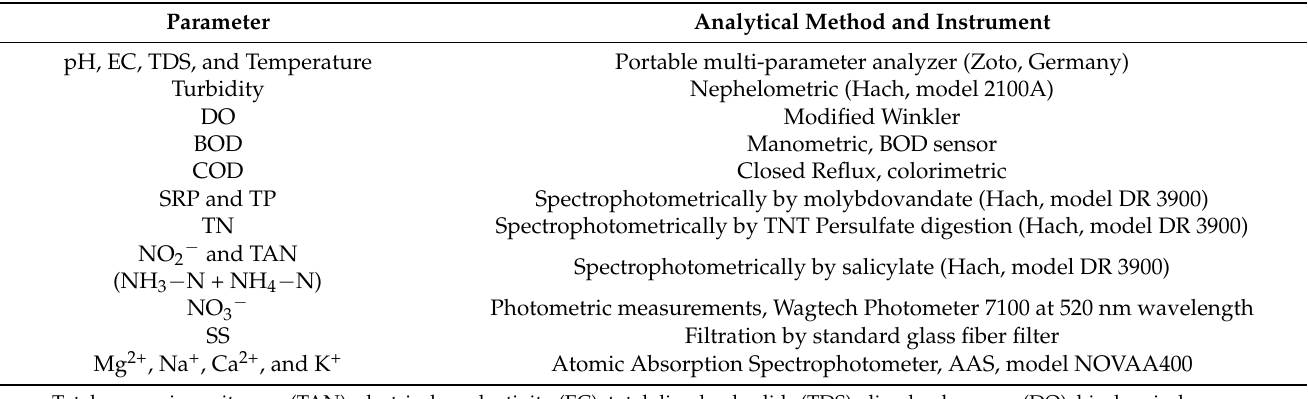
Table 2. Analytical methods and instruments used for